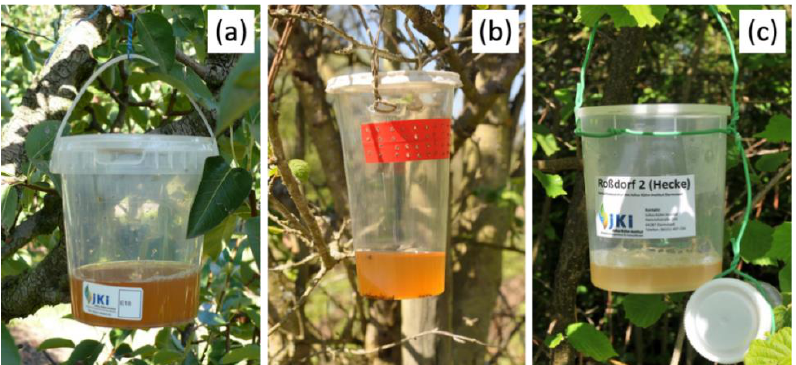
Figure 2. Monitoring traps: ( a ) JKI Dos, ( b ) JKI Sie, ( c ) JKI Dar. Photos: F.B., C.H., C.E.